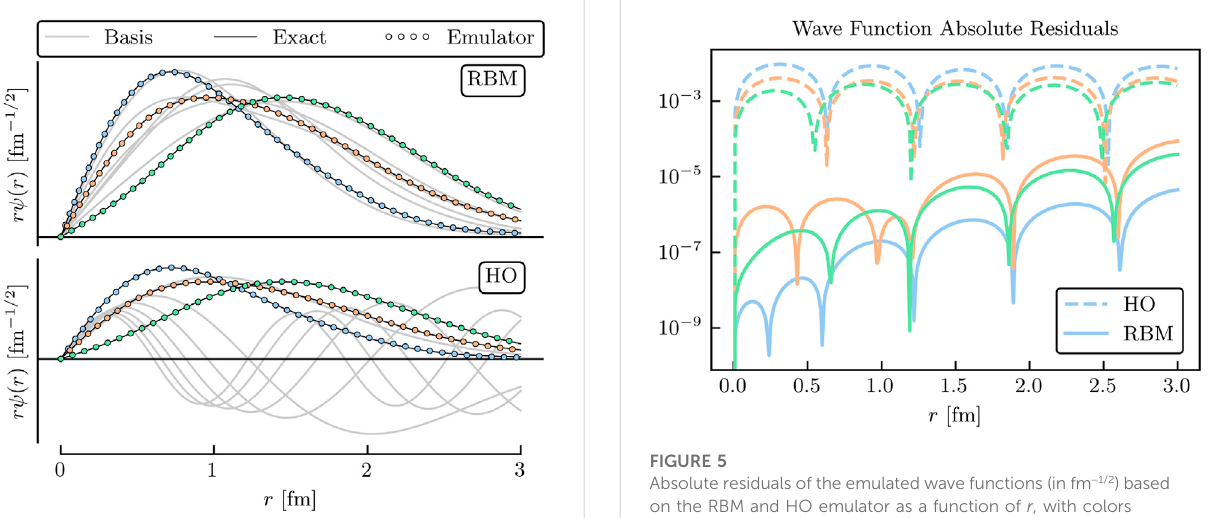
FIGURE 4 Emulated wave functions for the RBM emulator (top panel) and HO emulator (bottom panel) as a function of the radius. The solid black lines represent the exact solution, and the dots represent the emulator result. The gray lines give the wave functions used to train the emulator. See the main text for details.